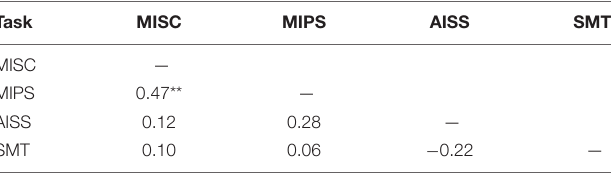
TABLE 4 | Correlations using all accrual rates in MIPS and AISS.